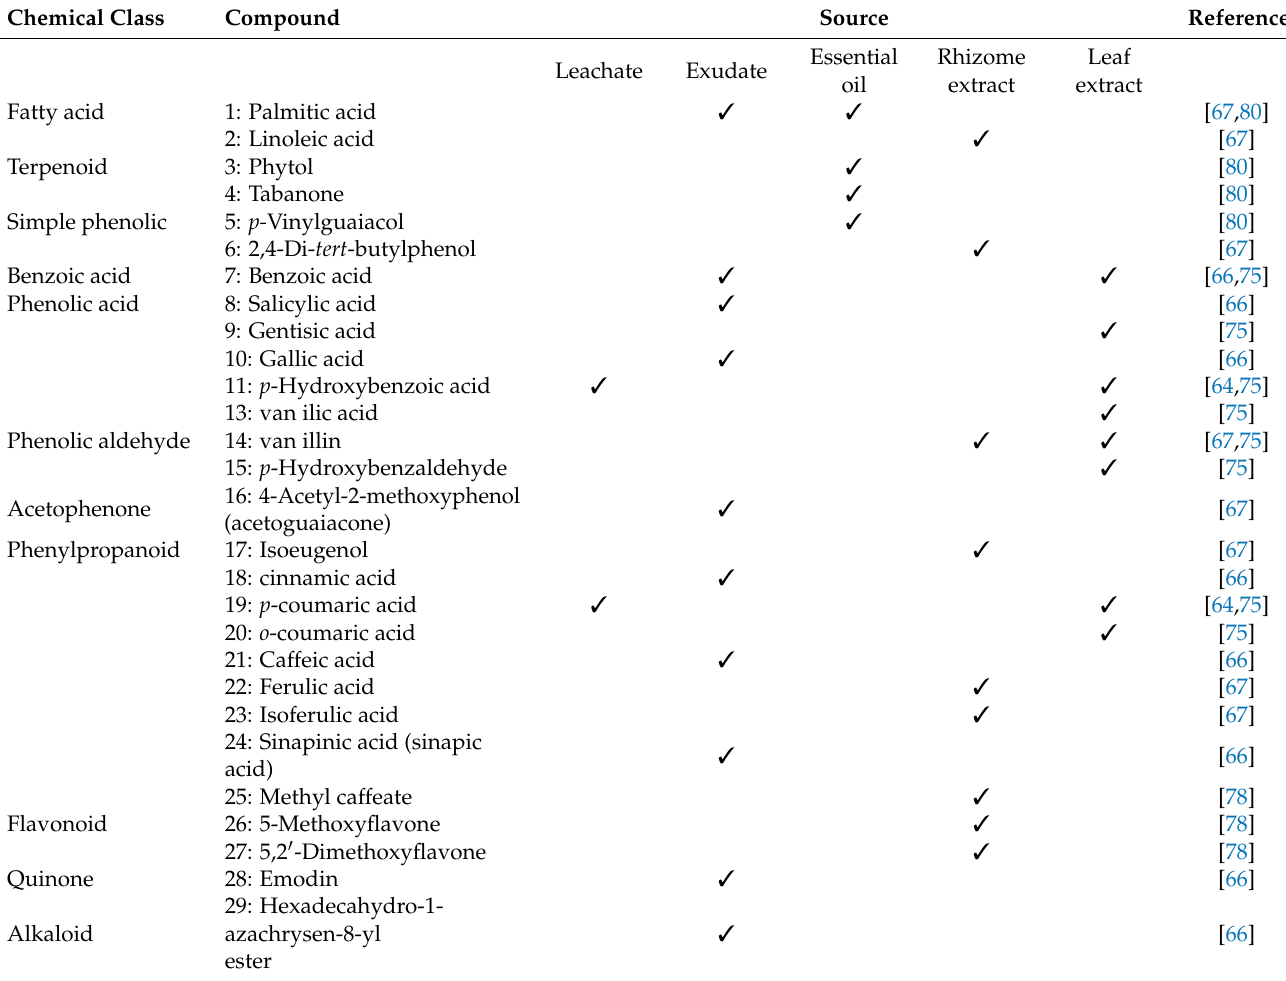
Table 2. Allelochemicals identified in Imperata cylindrica and their